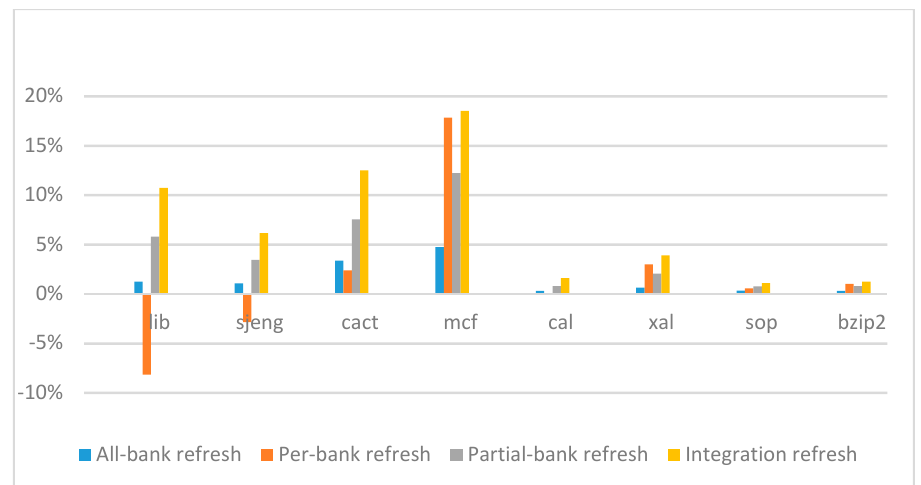
Figure 15. IPC improvement normalized to 1x granularity baseline (tRFC = 530 ns, weak row = 2%).